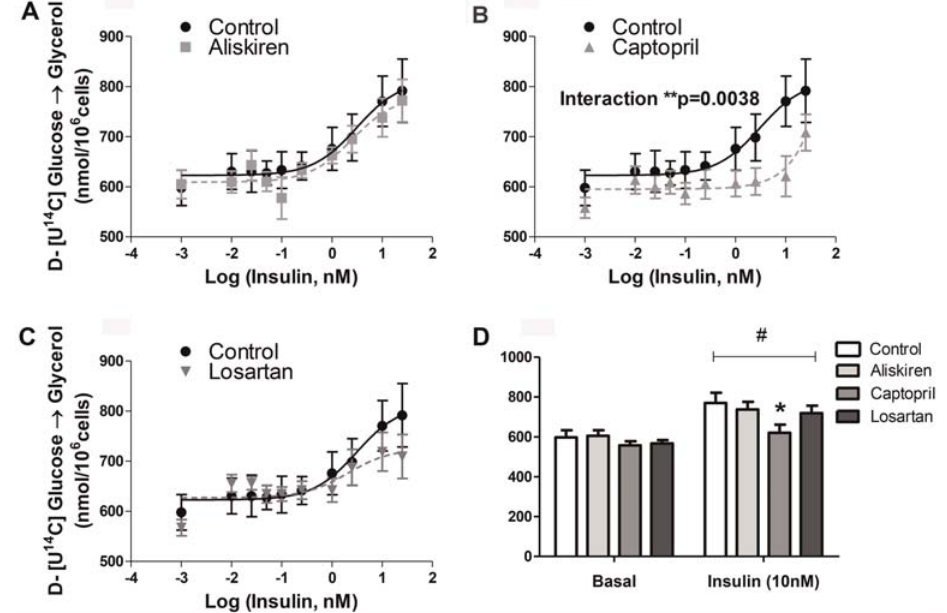
Figure 4. Glycerol glucose incorporation of isolated fat cells previously treated with renin-angiotensin system blockers ( A ) aliskiren, ( B ) captopril and ( C ) losartan. Cells were incubated with increasing concentrations of insulin for 60 min at 37°C. D-[U- 14 C]-glucose (0.05 m Ci/tube) was added to the incubation medium at the beginning of the test. At the end, adipocyte lipid content was extracted, and the radioactivity incorporated in glycerol was determined. D , basal and 10 nM insulin-stimulated lipogenesis. *P o 0.05 captopril vs control, in 10 nM insulin-stimulated state. There was also signi fi cant lipogenic stimulus ( # P o 0.001 for basal vs 10 nM insulin). Data are reported as the mean ± SE (n=6). Two-way ANOVA and the Bonferroni ’ s post hoc tests were